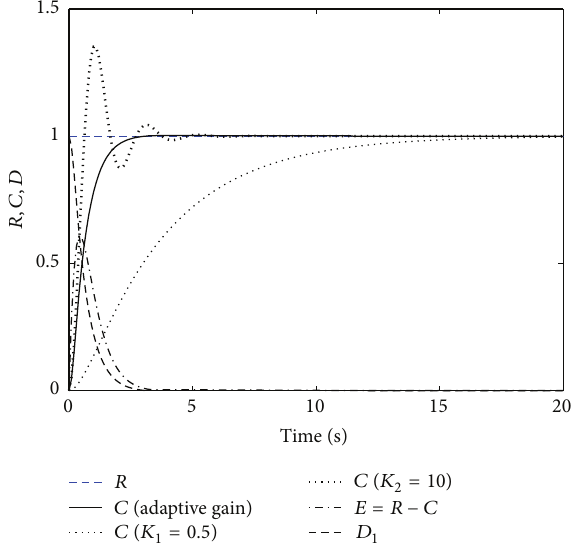
Figure 5: Time responses of the illustrating example for 𝑅 = 1 and /(𝑇 𝑠 + 1) . 𝐷(𝑠) = 𝐾 𝑛 𝑛